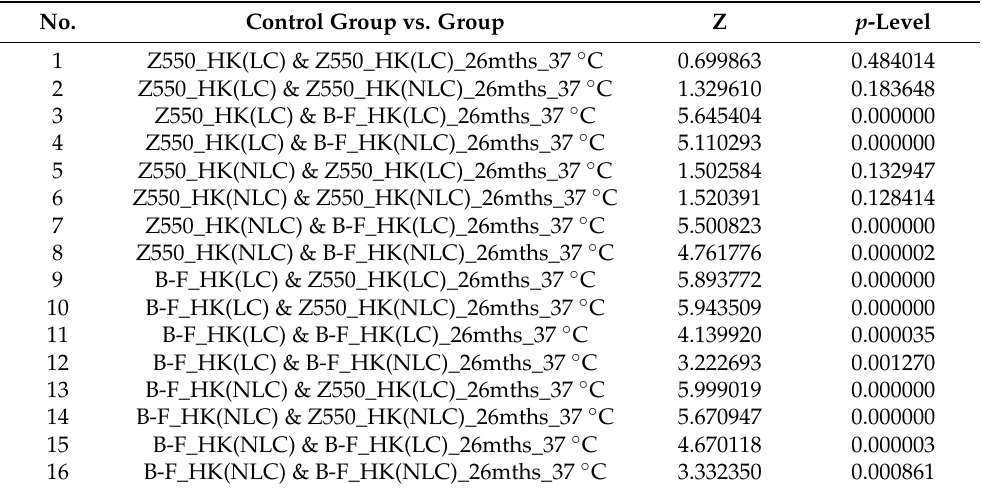
Table 5. Wilcoxon test results. The significance of the differences in the microhardness of the aged specimens for one month and specimens aged for 26 months. LC—light-cured surface of sample (the top side of a sample), NLC—non-light-cured surface (the bottom side of a sample), HK—Knoop hardness. No. Control Group vs. Group Z